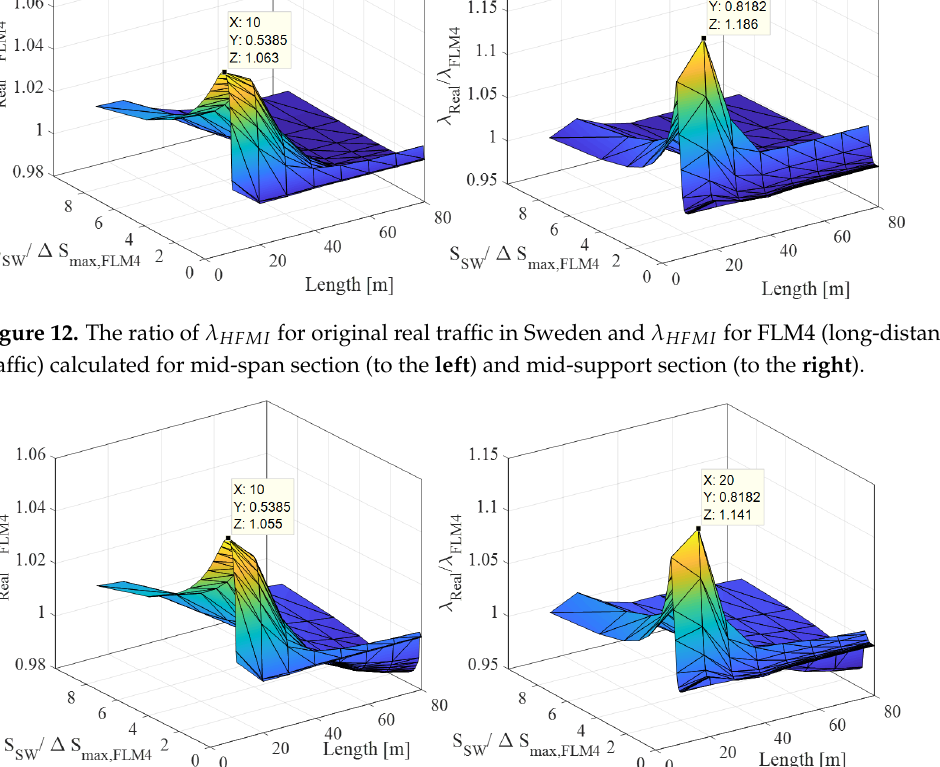
Figure 13. The ratio of λ HFMI for original real traffic in Sweden and λ HFMI for FLM4 (medium- distance traffic) calculated for mid-span section (to the left ) and mid-support section (to the right